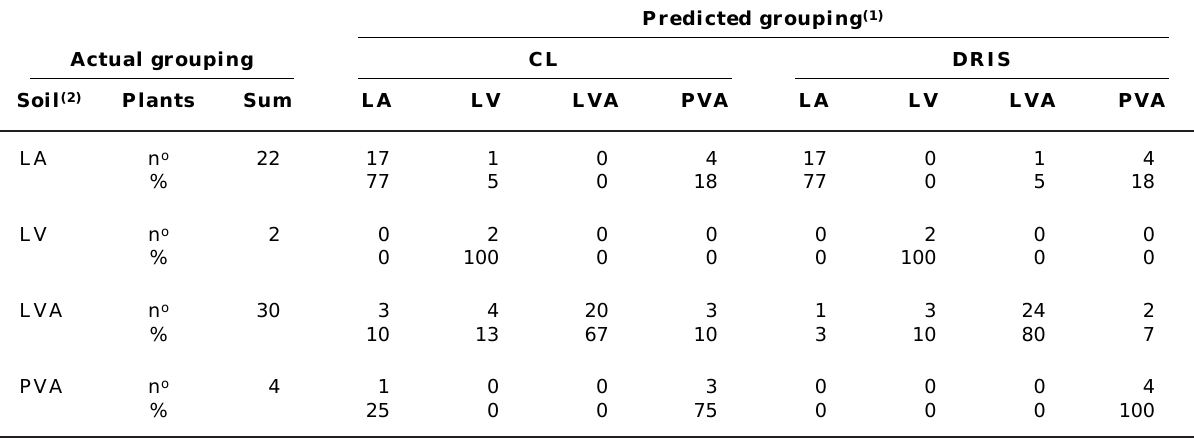
(1) 72.4% or 83.3% of the coffee crops were correctly classified in the actual soil class by CL and DRIS methods, respectively. (2) LA: Yellow Latossol, LV: Red Latossol, LVA: Red-Yellow Latossol, PVA: Red-Yellow Argissol.